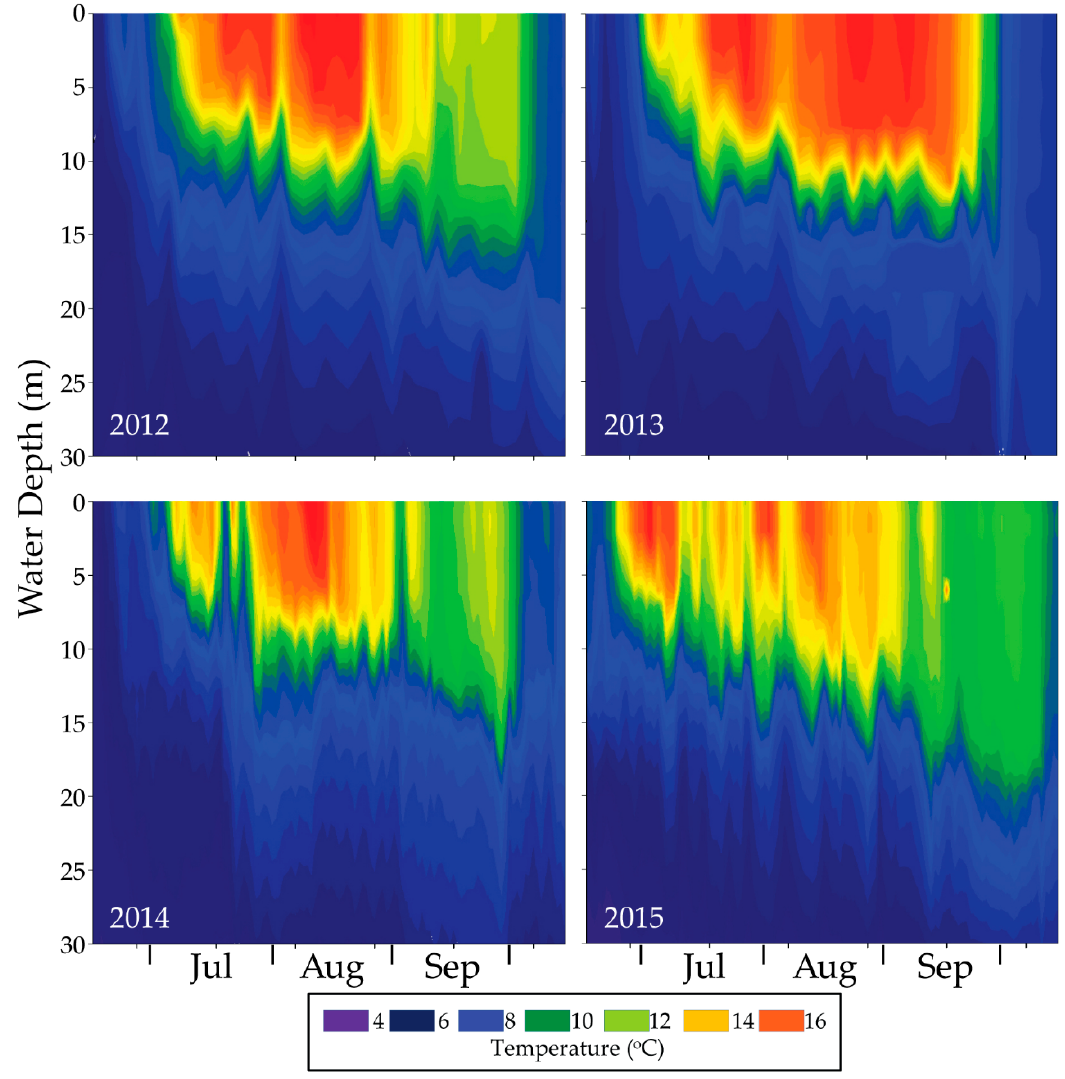
Figure A1. Depths of isotherms (°C) measured using a multiparameter sonde (Hydrolab Surveyor) in the West Thumb of Yellowstone Lake during a portion of the ice-free period, 2012–2015. The thermal structure of Yellowstone Lake is typically unstable with a weak and variable thermocline in July, August, and September. During nine months of each year, there is no thermal cause for segregation of invasive lake trout and native cutthroat trout. Only the upper 30 m are shown for better resolution of surface water